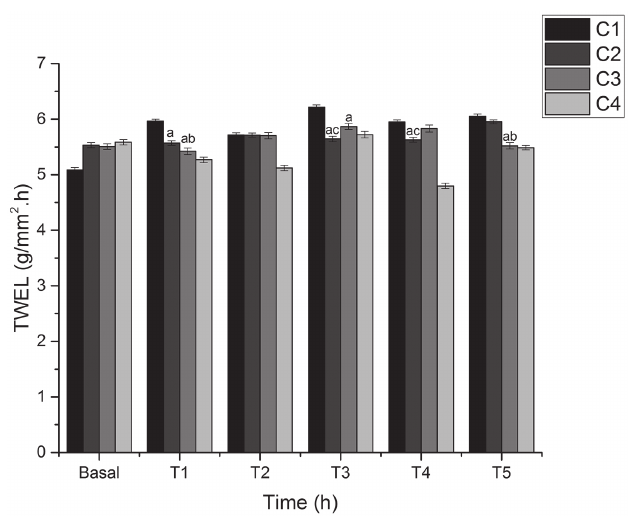
FIGURE 2 ‑ Transepidermal water loss (Mean ± SE) measured before and 1, 2, 3, 4 and 5 hours after a single application of formulations. Notes: a =p-value < 0.05 for ANOVA + Bonferroni post test vs. negative control; b=p-value < 0.05 for ANOVA + Bonferroni post test vs. C2. C1 – Negative control; C2 –